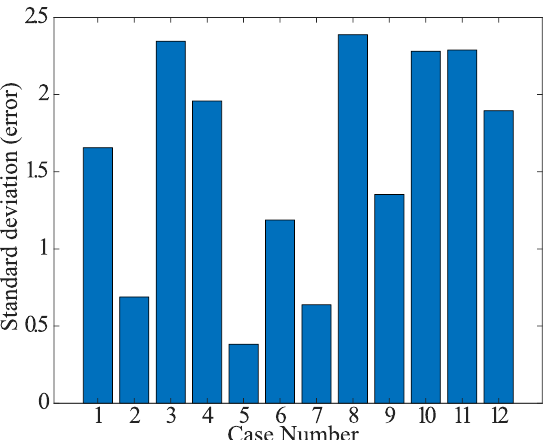
Figure 25. Comparison of each data in Table 2 (standerd